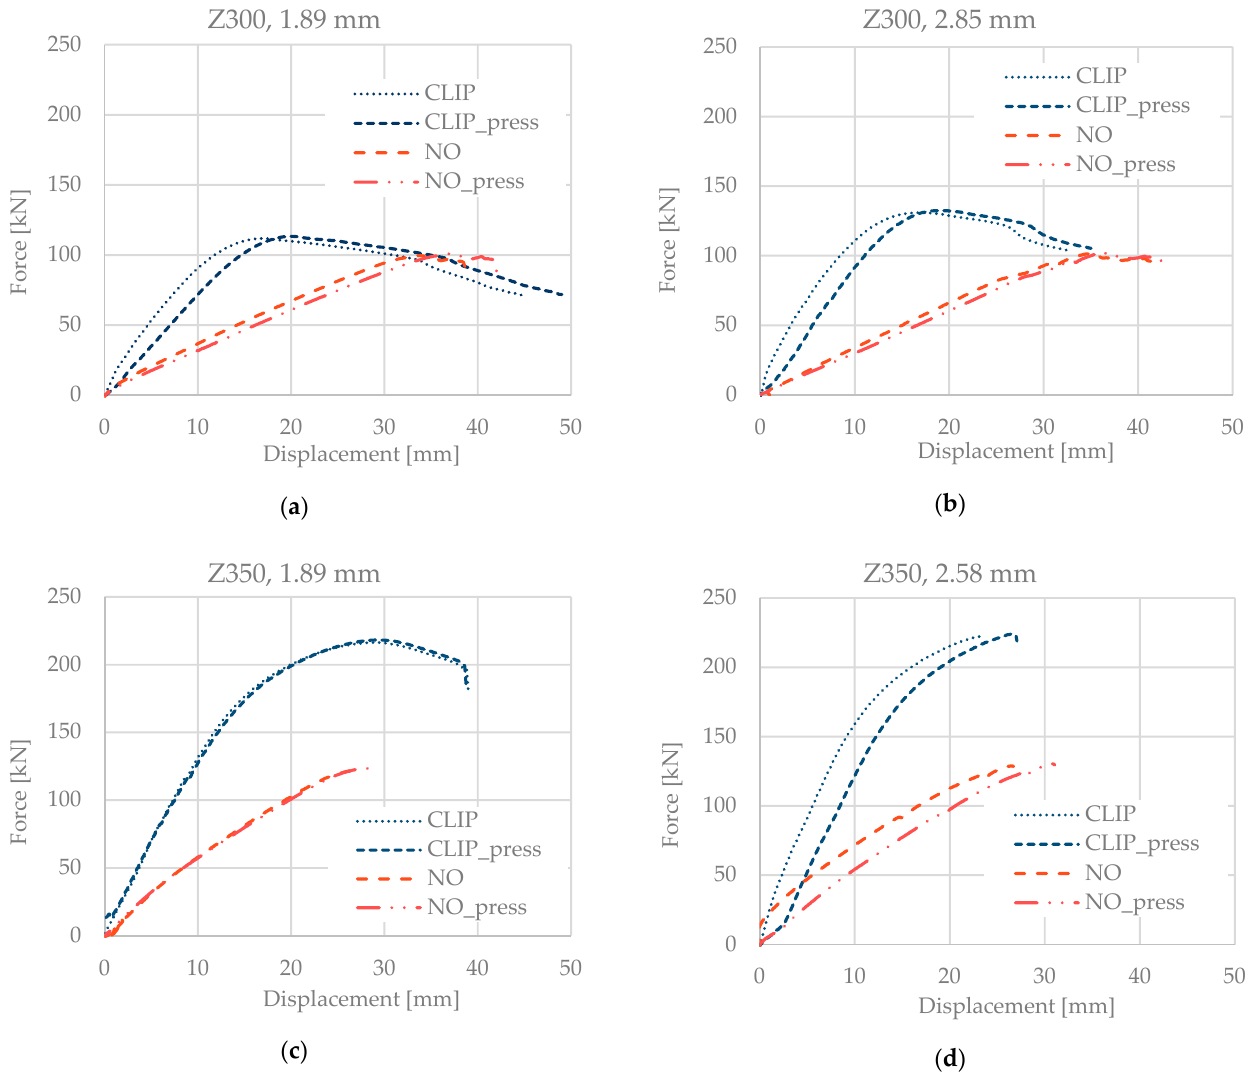
Figure 6. Force–displacement graphs for ( a ) Z300, 1.89 mm; ( b ) Z300, 2.85 mm; ( c ) Z350, 1.89 mm; and ( d ) Z350, 2.85 mm.